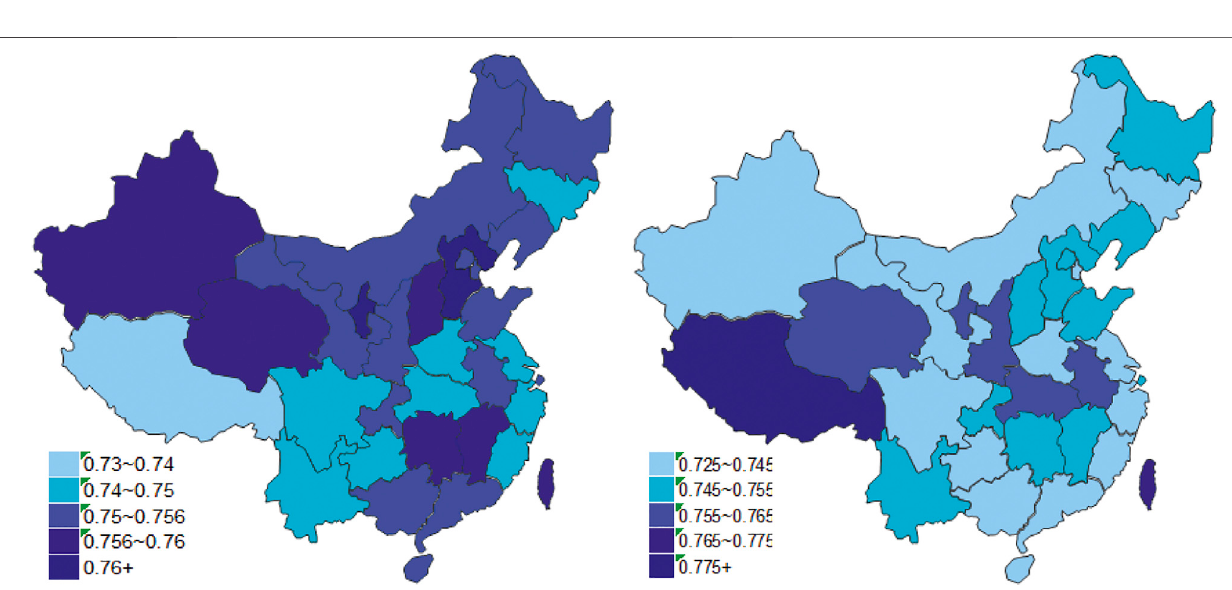
FIGURE 8 | The comparison of clustering coef fi cient between 2011 and